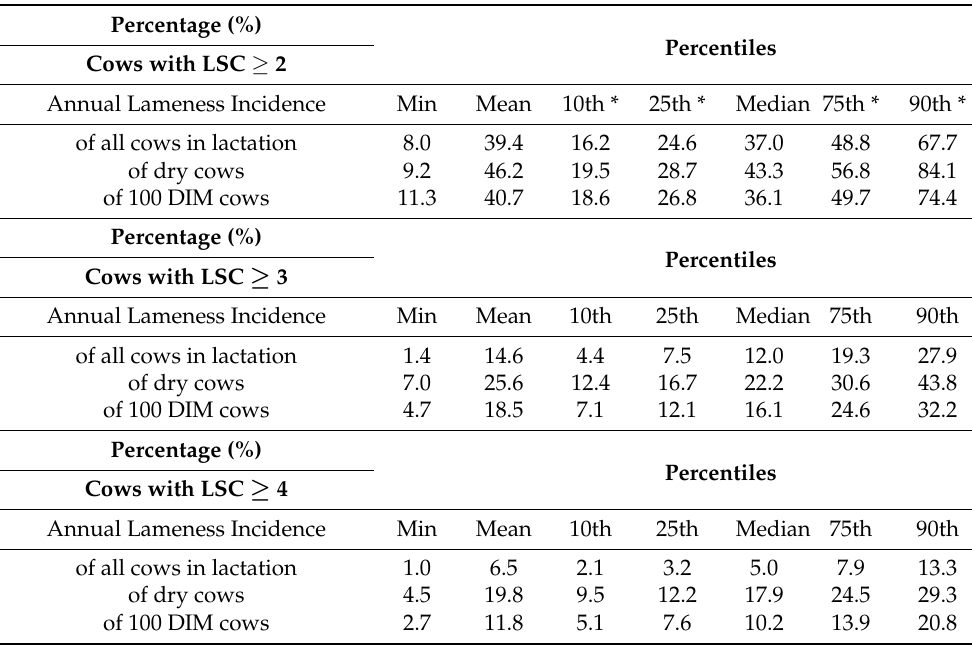
Table 3. Benchmarking lameness incidence at cow level per herd calculated as mean lameness incidence risk of all locomotion scores during one lactation period in 2020 with LSC ≥ 2, LSC ≥ 3 and LSC ≥ 4 by classification of the 99 herds using percentiles arranged into the min (minimum), mean, median, 10th, 25th, 75th and 90th percentiles; DIM: days in